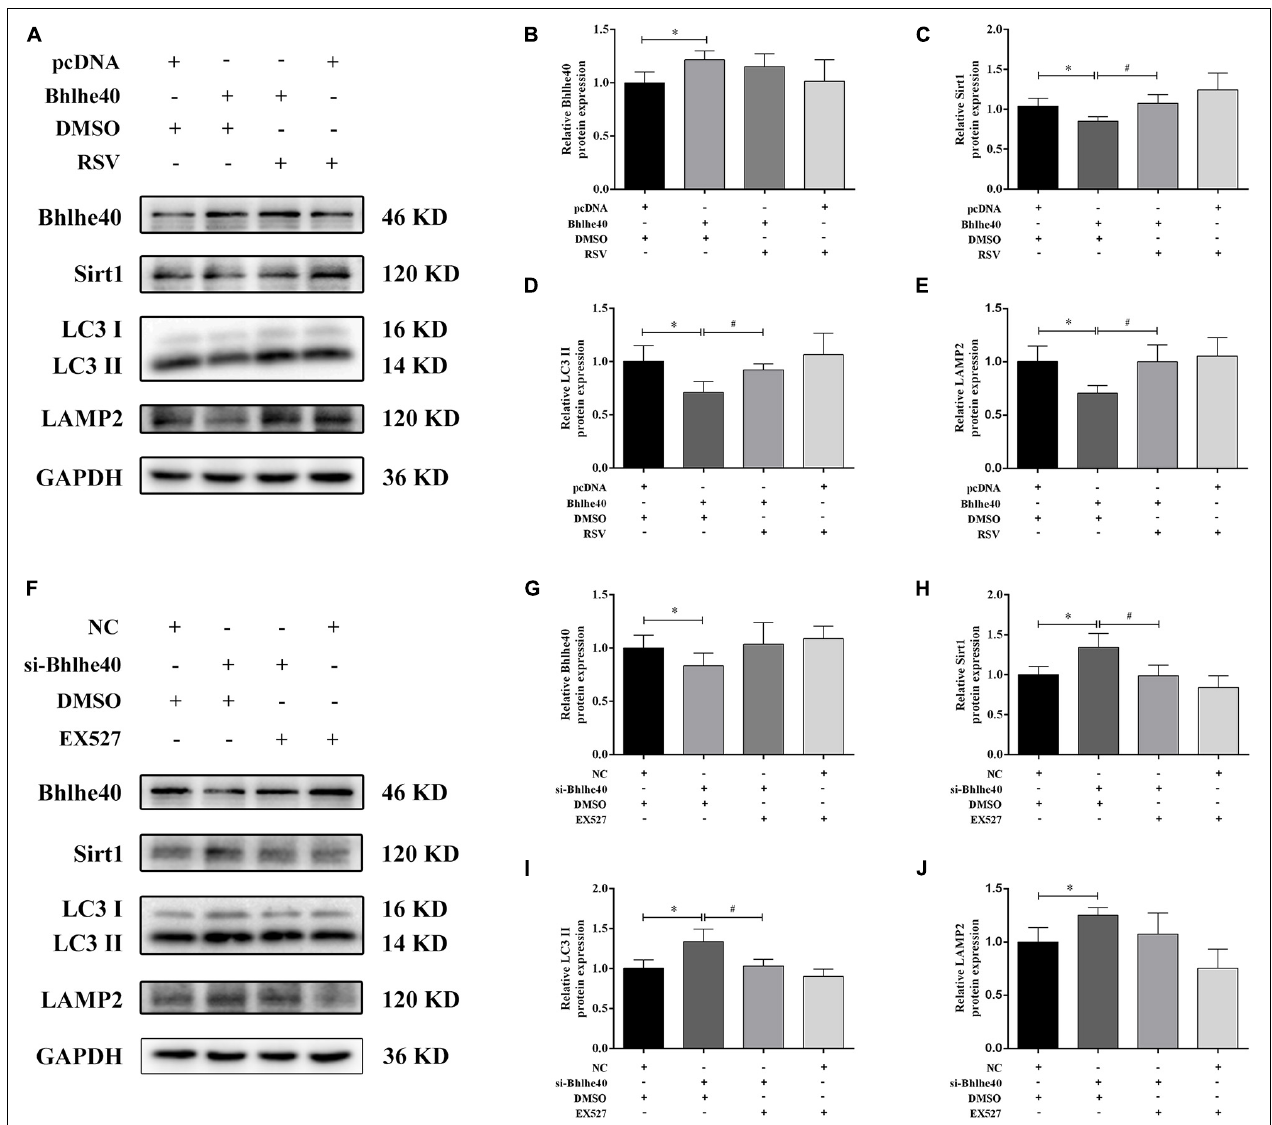
FIGURE 7 | The Bhlhe40/Sirt1 axis regulates autophagy/mitophagy-related proteins in C17.2 cells. (A) Western blot analysis of Bhlhe40, Sirt1, LC3, and LAMP2 protein levels in C17.2 cells treated with different combinations of pcDNA, Bhlhe40, DMSO, and RSV. Quantitation of Bhlhe40 (B) , Sirt1 (C) , LC3 II (D) , and LAMP2 (E) protein ( n = 3). Results are expressed as the mean ± SD. ∗ p < 0.05 vs. pcDNA + DMSO group; # p < 0.05 vs. Bhlhe40 + DMSO group. (F) Western blot analysis of Bhlhe40, Sirt1, LC3 II, and LAMP2 protein in C17.2 cells treated with different combinations of NC, si-Bhlhe40, DMSO, and EX527. Quantitation of Bhlhe40 (G) , Sirt1 (H) , LC3 (I) , and LAMP2 (J) protein ( n = 3). Results are expressed as the mean ± SD. ∗ p < 0.05 vs. NC + DMSO group; # p < 0.05 vs. si-Bhlhe40 + DMSO